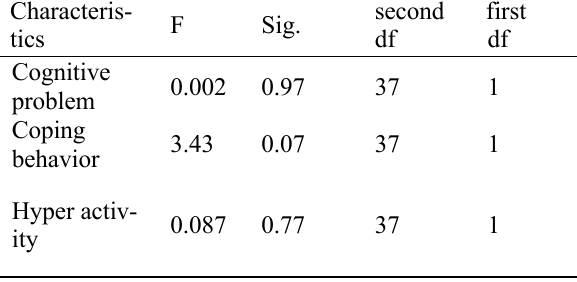
Table 4. Results of Levene’s test for equality of variances of the two groups in the scores of attention deficit hyperactivity in post-test.